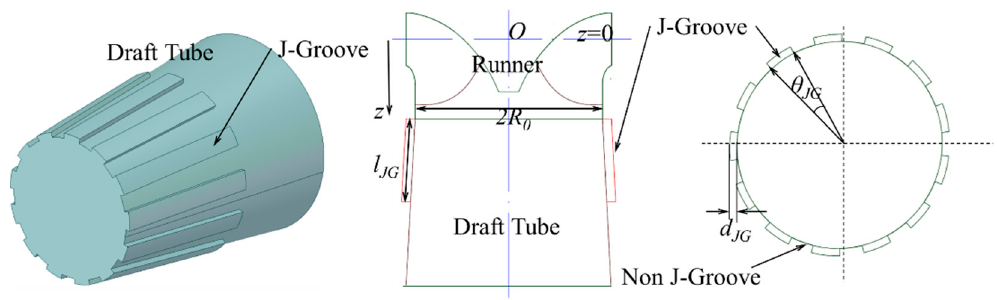
Figure 6. J-Groove shape install on the draft tube inner wall and design parameters.